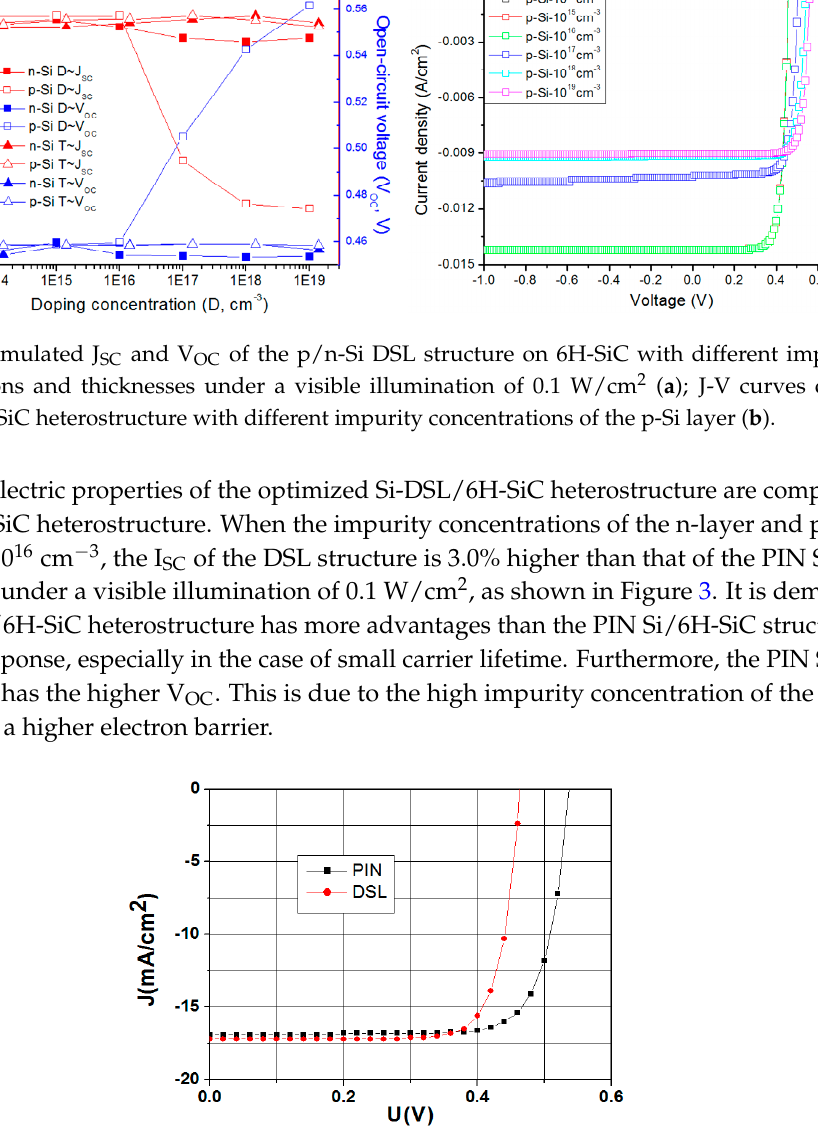
Figure 3. Simulated J-V curves of Si-DSL/6H-SiC heterostructure and PIN Si/6H-SiC heterostructure under a visible illumination of 0.1 W/cm 2 .